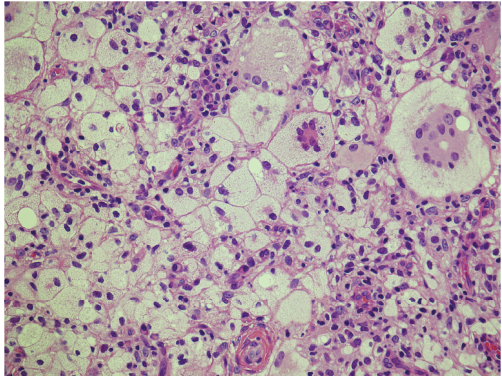
Figure 4: Microscopically, specimen demonstrated xanthogranu- loma in the external auditory canal (hematoxylin and eosin,